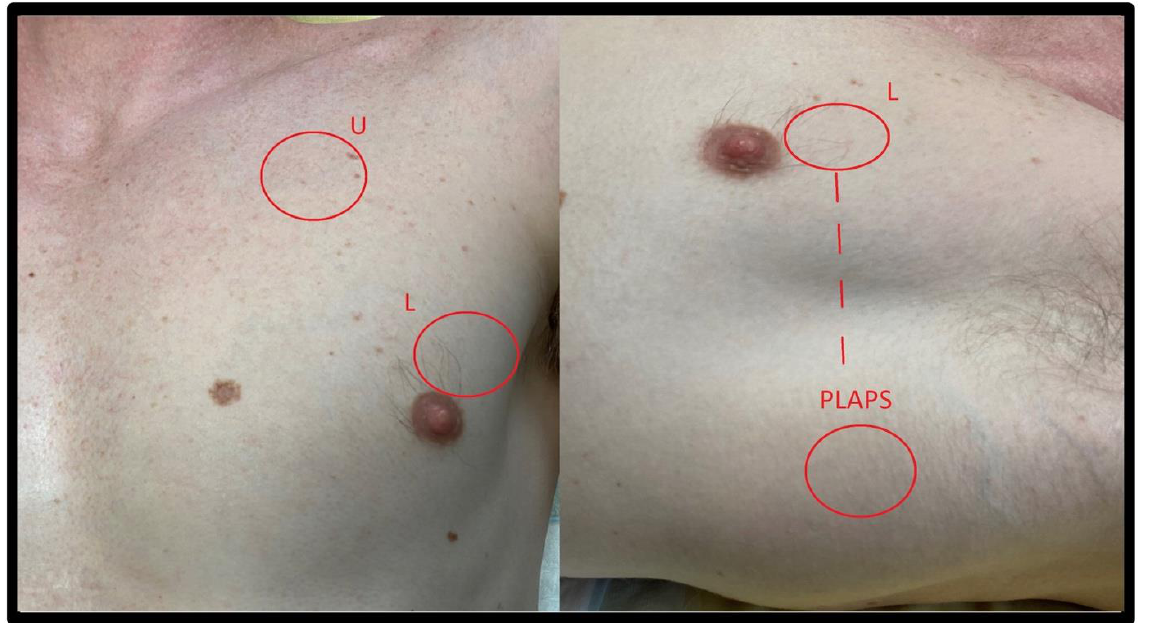
Figure 3. BLUE Protocol chest areas. Three areas of interest to explore according to BLUE protocol U: The upper BLUE-areas is at the middle of a virtual hand placed along the clavicula. L: The lower BLUE-areas is at the middle of the palm of another virtual hand placed below the first one. PLAPS: The PLAPS-areas (PosteroLateral Alveolar and Pleural Syndrome) is placed in the horizontal continuation of the lower point in the posterior axillary line.